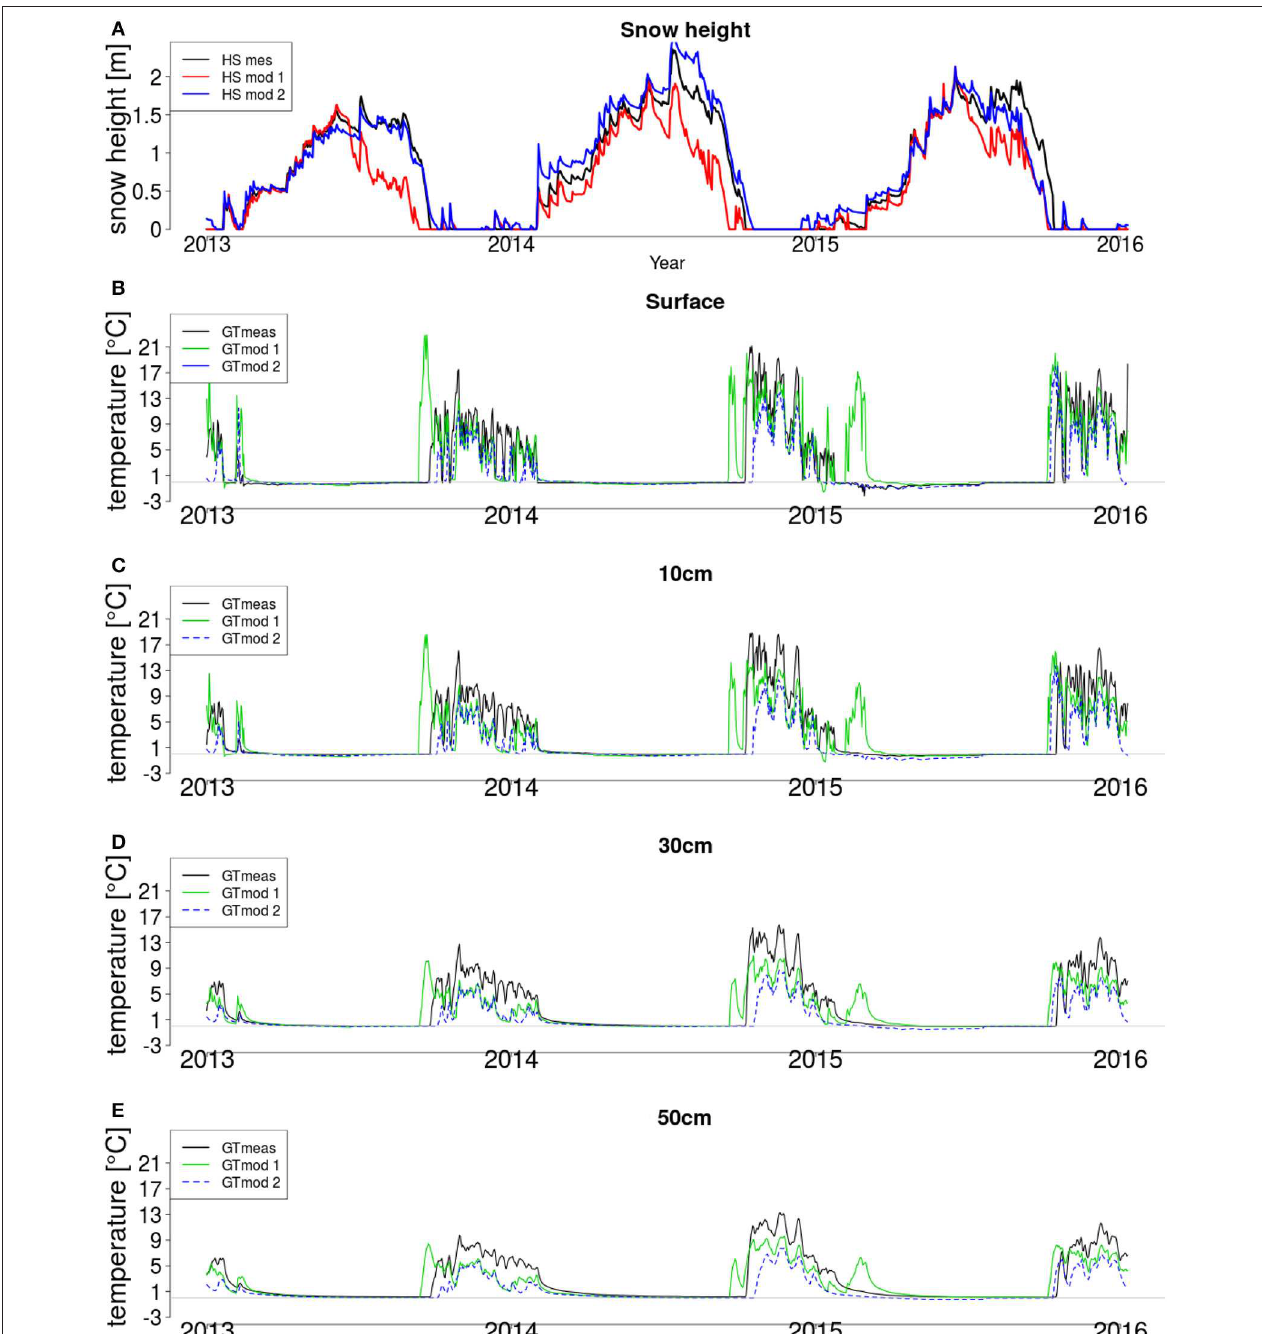
FIGURE 3 | Measured and modeled snow height (HS, A ) and ground temperature (GT) at surface (B) and at 10 (C) , 20 (D) , and 50 cm (E) depths for 2014–2016 at Weissfluhjoch (WFJ) station. The gray horizontal line indicates the zero degree line in each ground temperature plot.